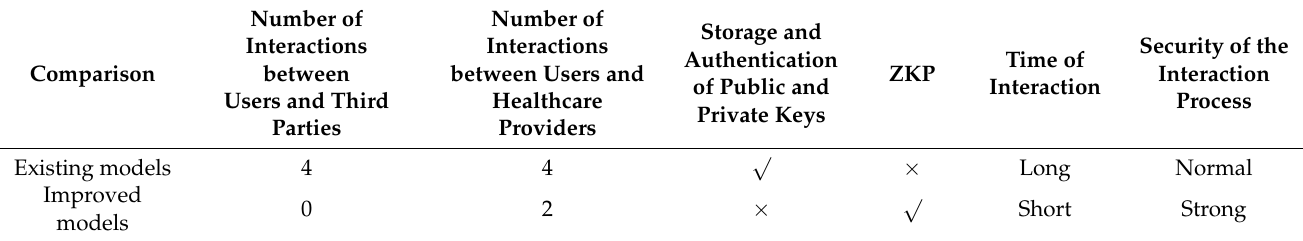
Table 3. Comparison of existing models and improved models.